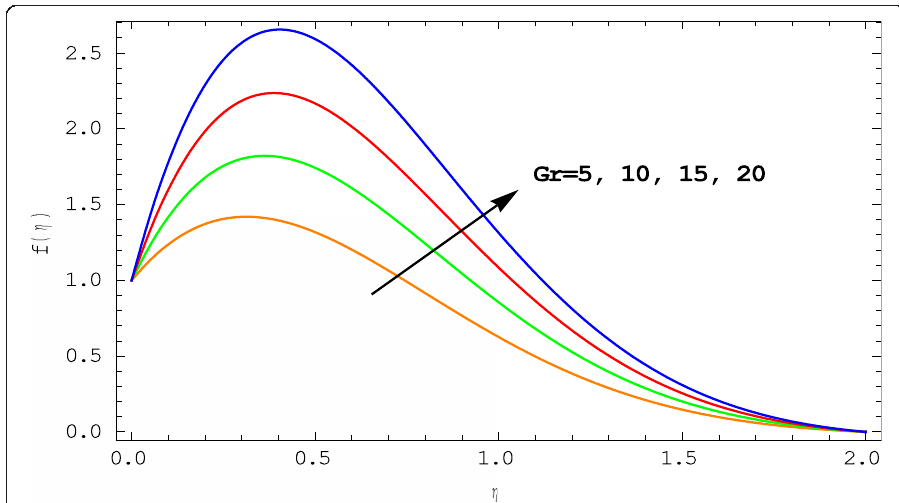
Fig. 5 Fluid velocity with increasing of the thermal Grashof number (G r